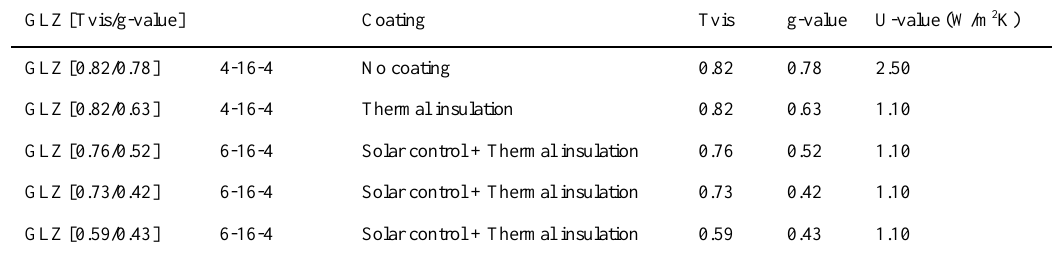
Table 1. Glazing characteristics